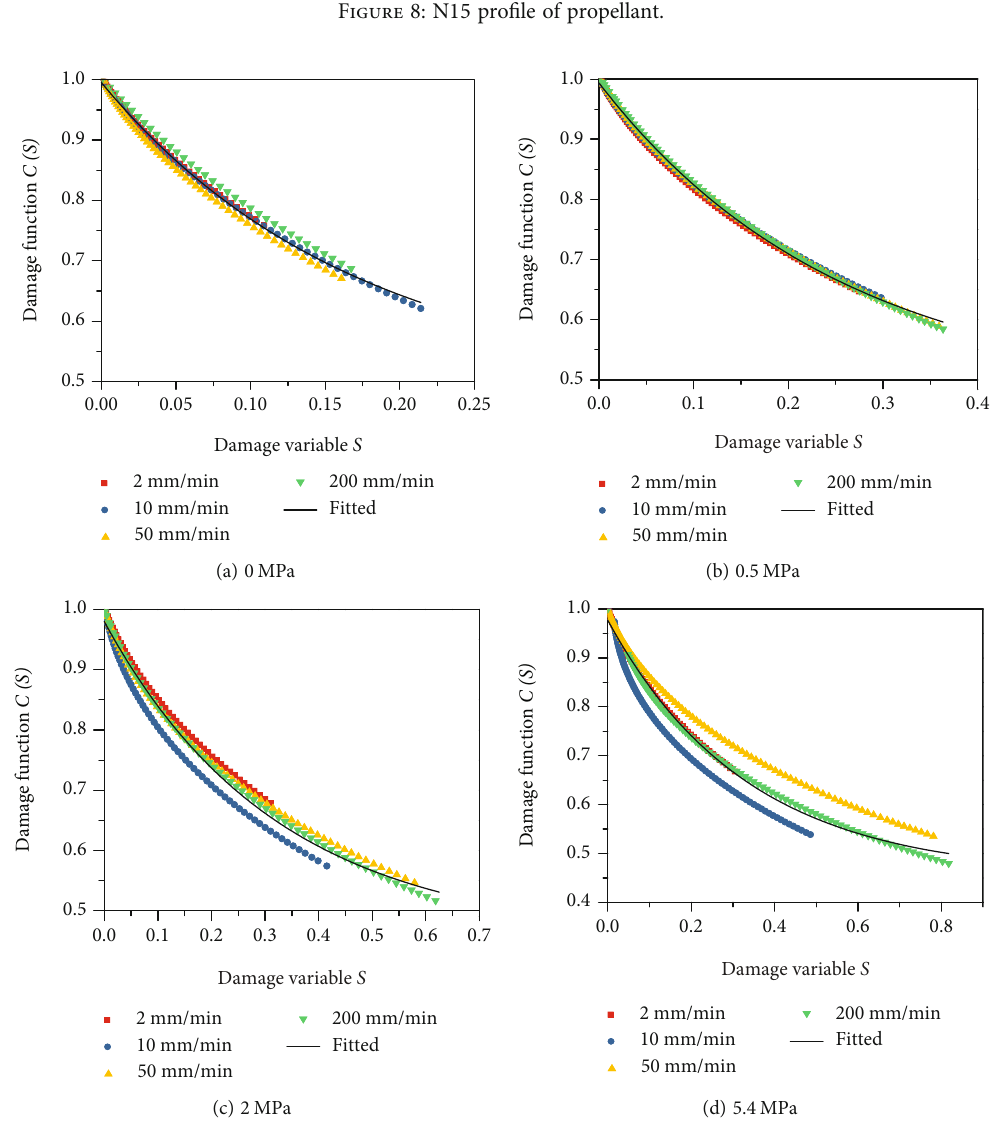
Figure 9: Graphs of environmental pressures C ð S Þ